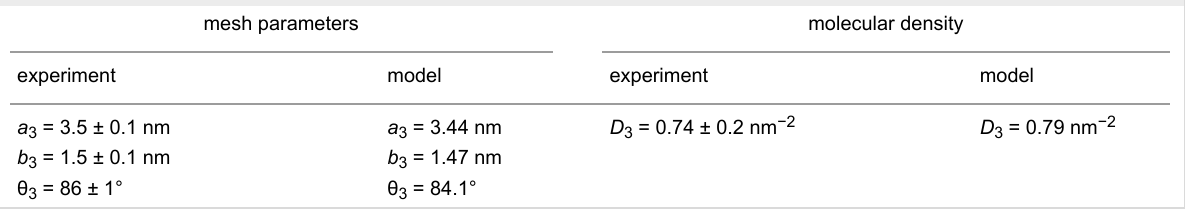
Table 2: Experimental and model parameters, respectively measured and calculated on C343 islands.